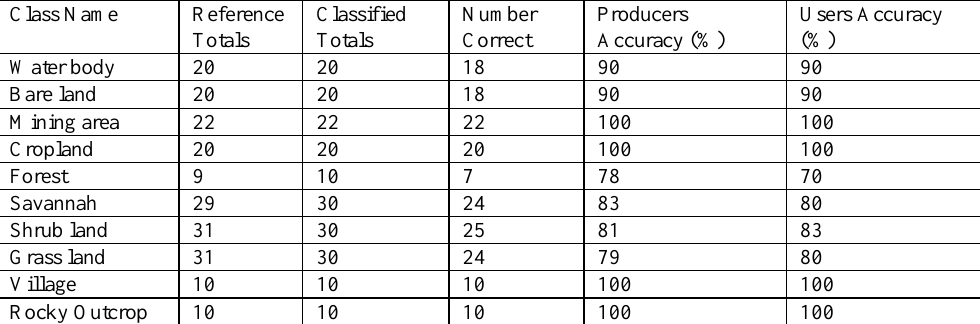
Table 1: Accuracy assessment of the 2014 dry season land use-land cover map Total samples= 202 Number correct= 178